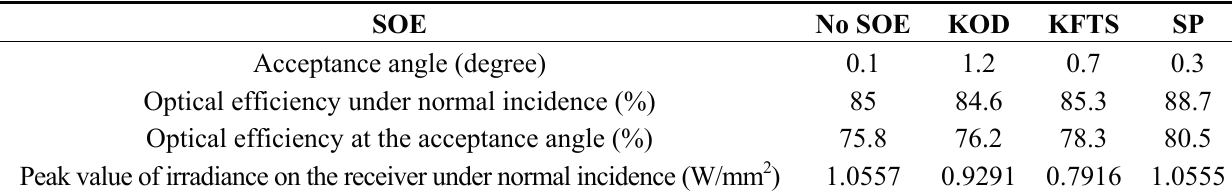
Table 2. Comparison of the optical performance of the Fresnel lens with three types of secondary optical elements (SOE).